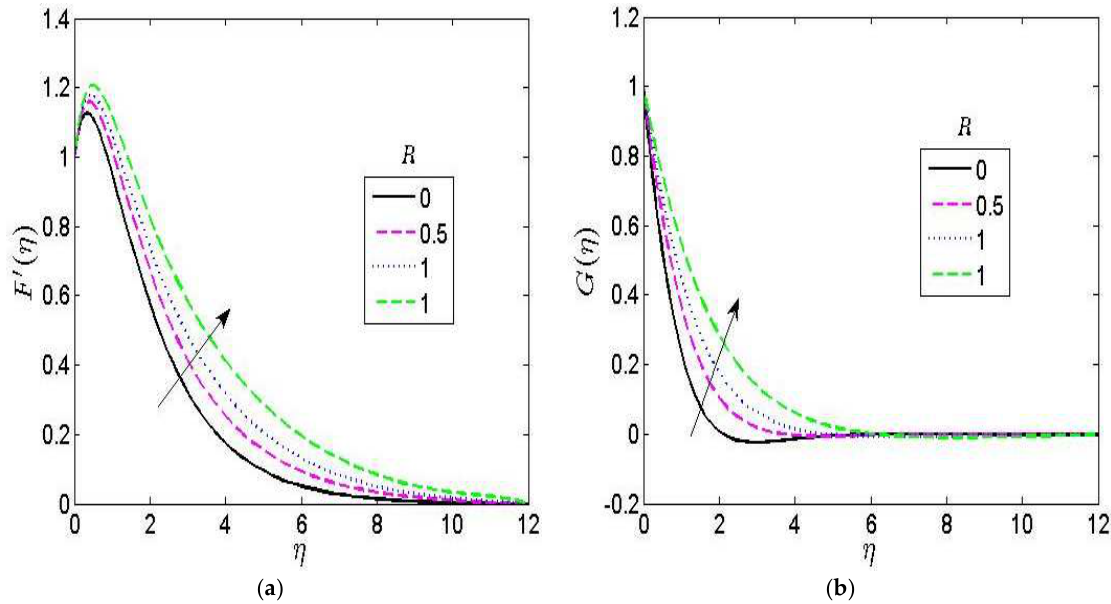
Figure 2. Effect of thermal radiation R on ( a ) velocity and ( b ) temperature profiles.